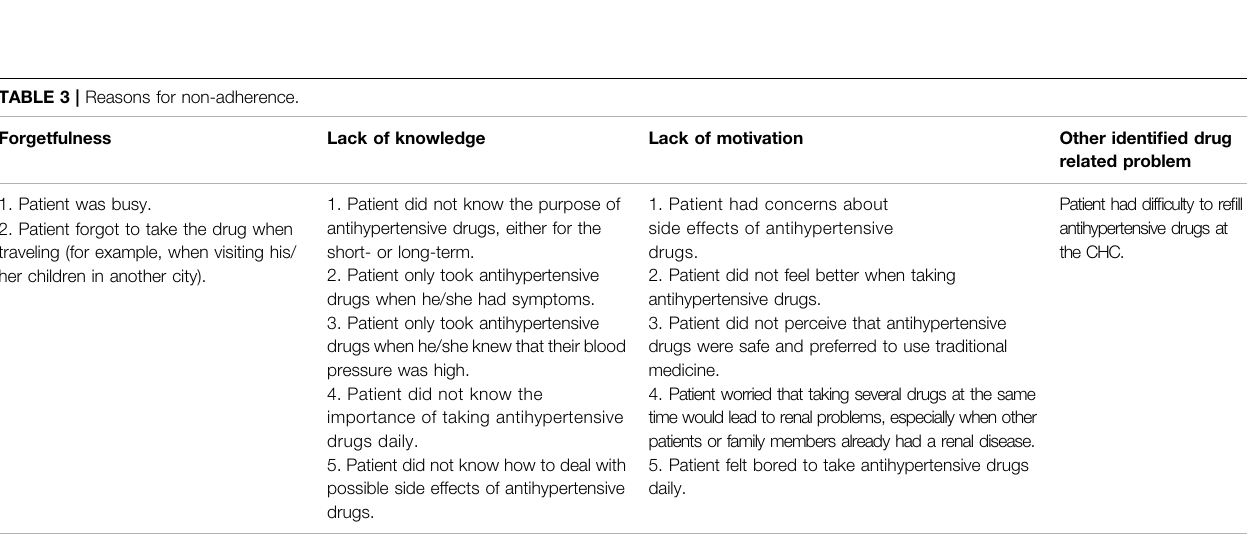
TABLE 3 | Reasons for